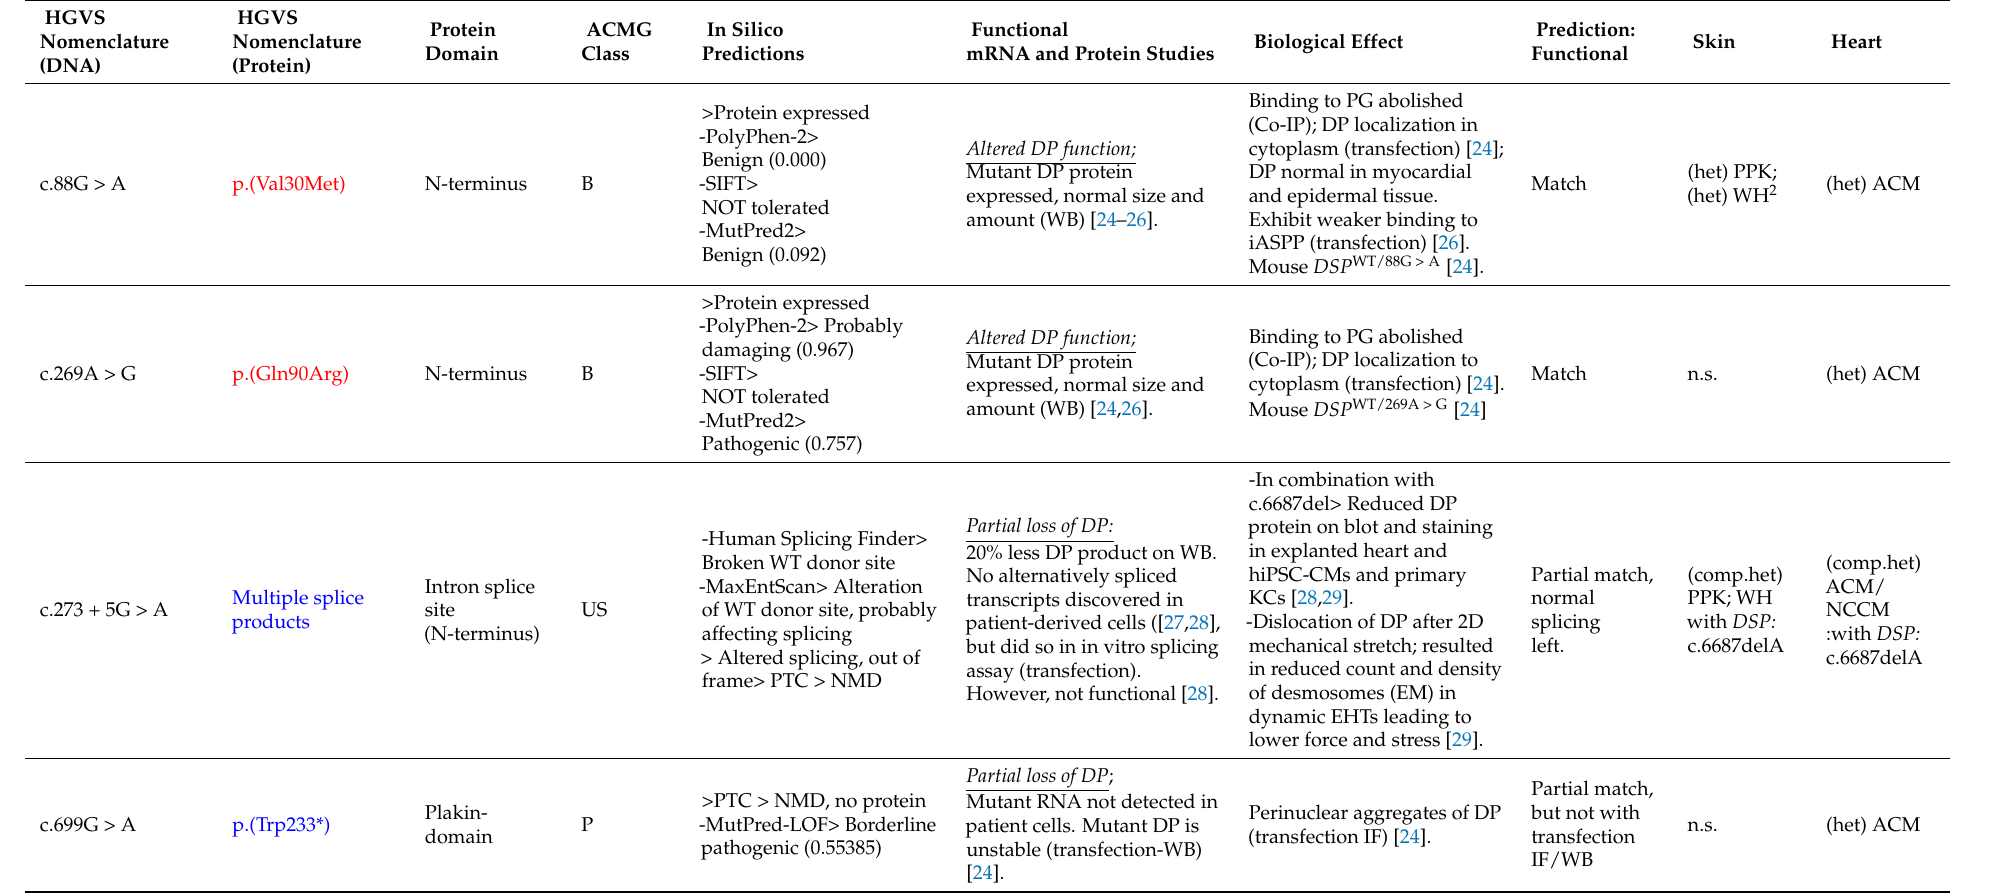
Table 1. Functionally analysed DSP